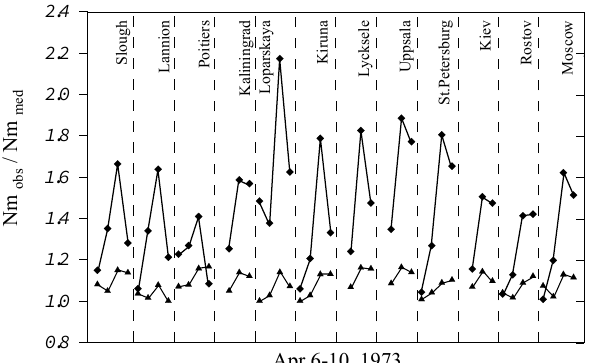
Figure. 1. Fig. 1. Observed δ Nm F2 (squares) and δ Nm E (triangles) values at 12 ionosonde stations for the 6–10 April 1973 period. The number of days with observations available is different for different